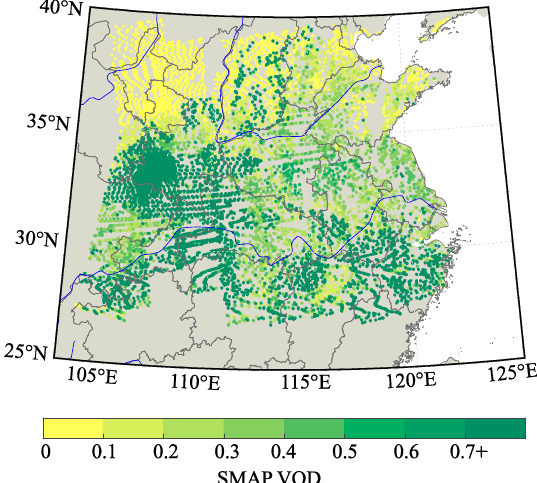
Figure 3. SMAP VOD estimates at 500-sample interval for the period 1–13 of April 2019. Units are dimensionless.